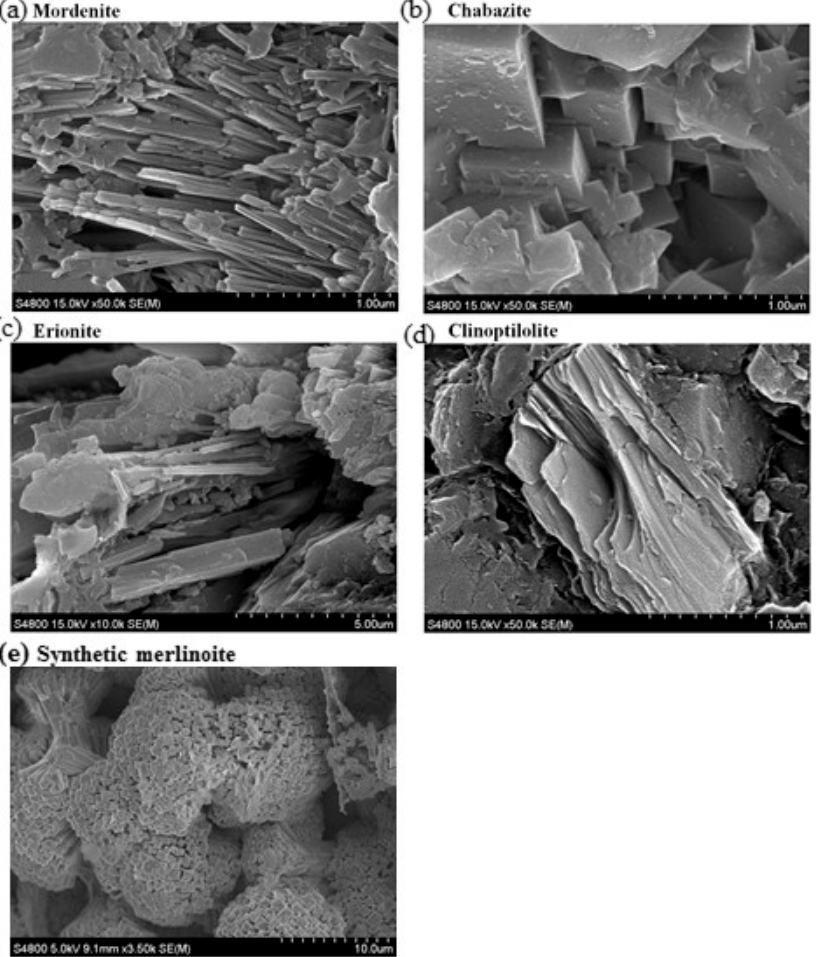
Figure 2. Morphology of the zeolites as found using Scanning Electron Microscopy. ( a ) Mordenite; ( b ) chabazite; ( c ) erionite; ( d ) clinoptilolite; and, ( e ) synthetic merlinoite.